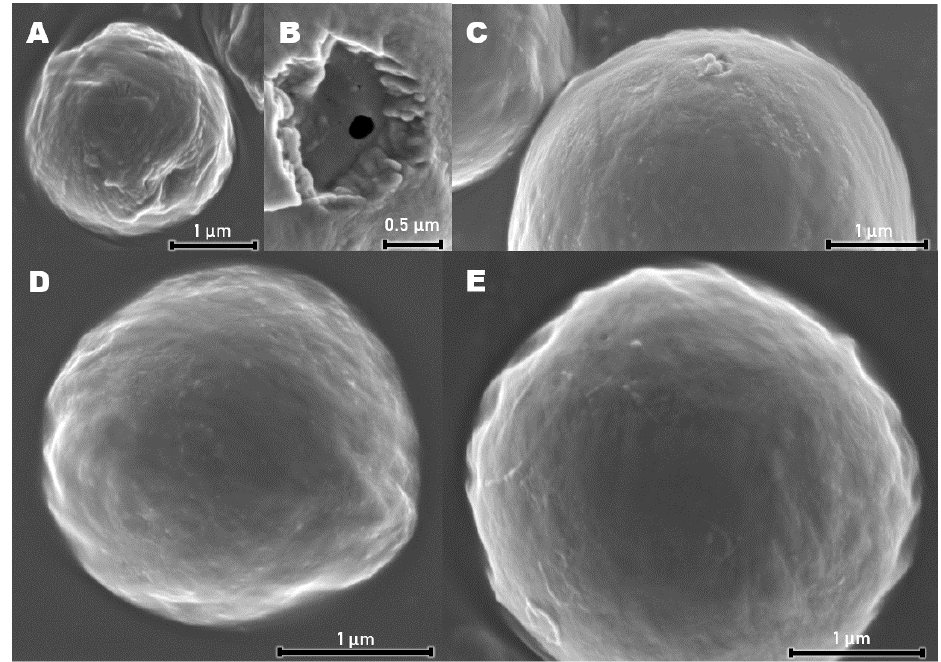
Figure 4. SEM micrographs of ( A , B ) PCL cores, and PCL cores coated with crosslinked tetralayer ( C ) PAH/HEP, ( D ) PEI/HEP and ( E ) CHIT/HEP shells. PAH/HEP, ( D ) PEI/HEP and ( E ) CHIT/HEP